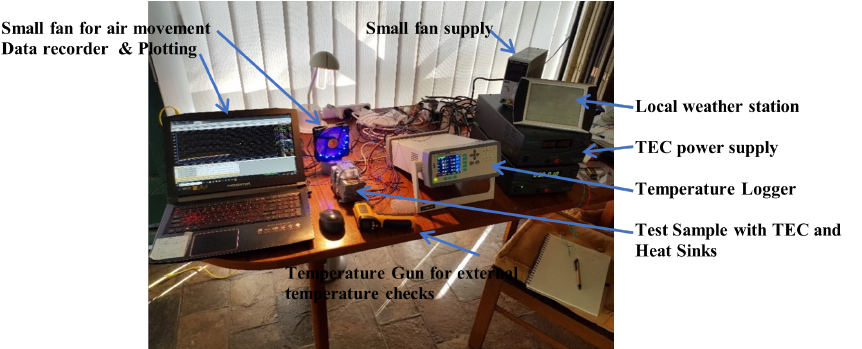
Figure 13. Layout of testing